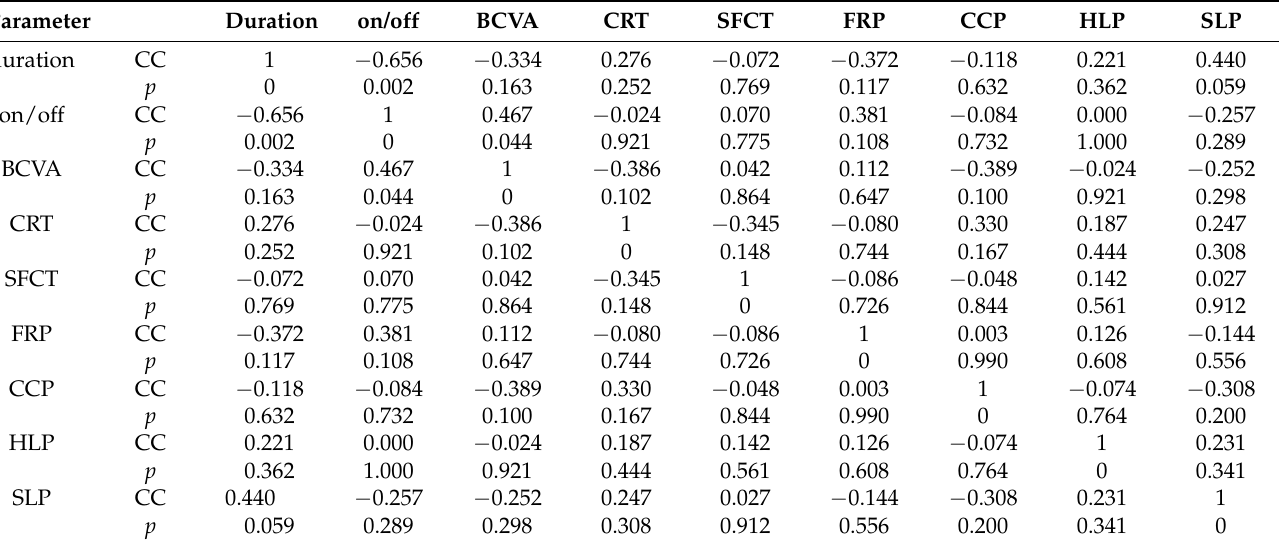
Table 4. Correlation analysis of functional and morphological data four weeks after silicone oil